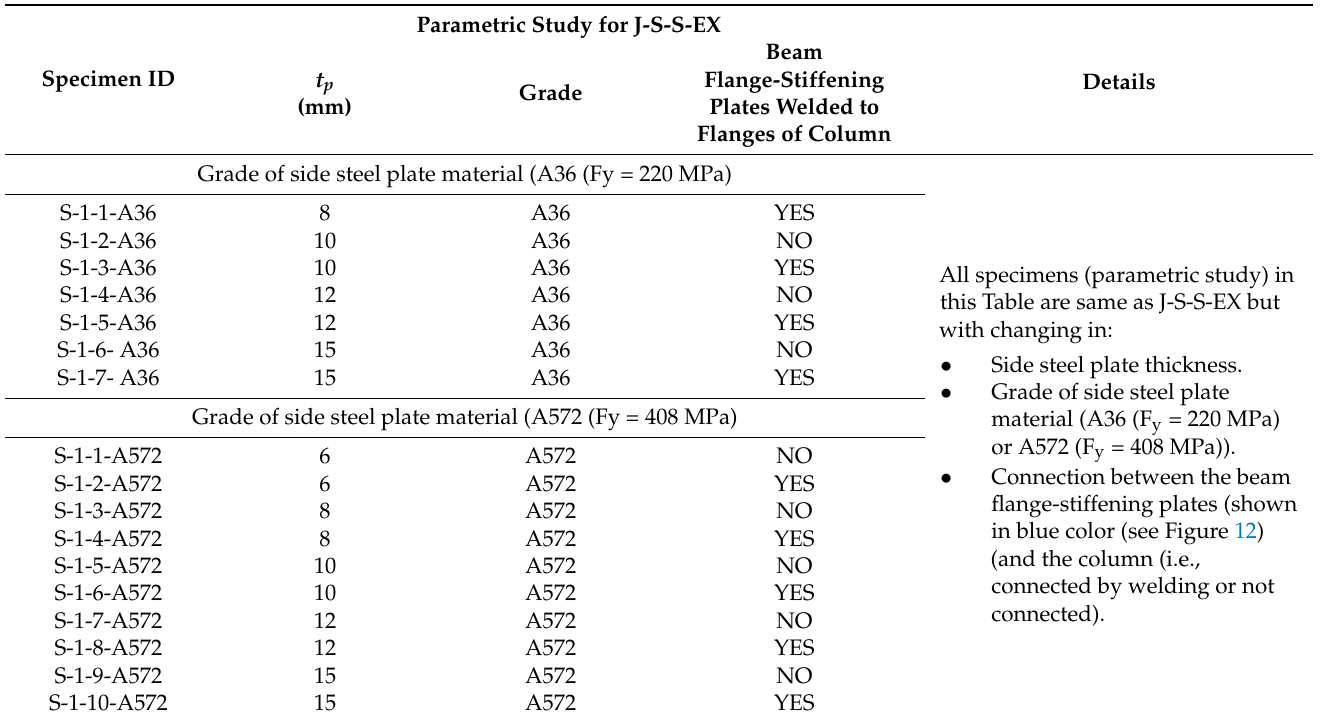
Table 4. Details of strengthened joints used in the investigation study for